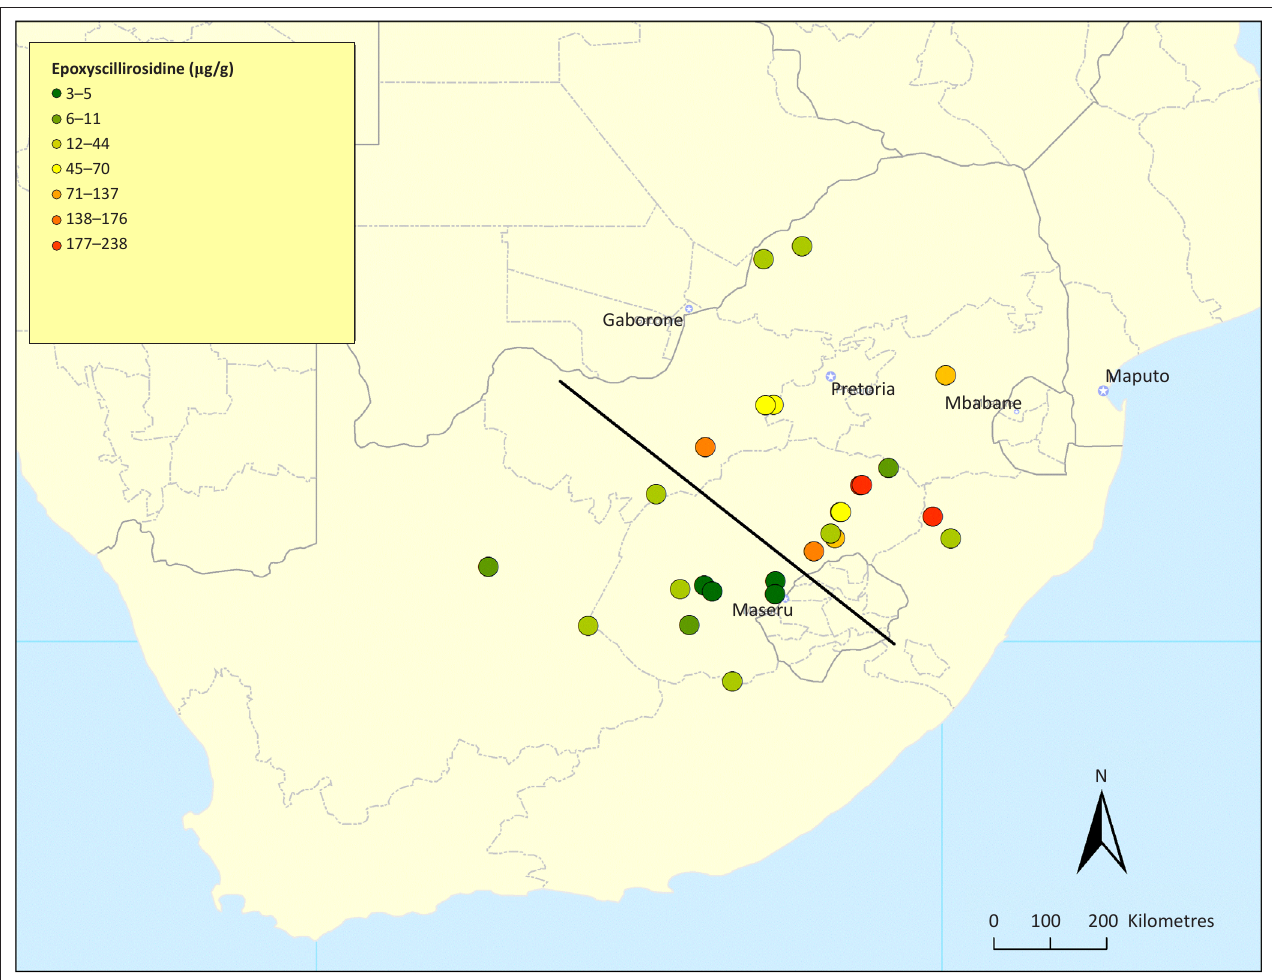
FIGURE 1: Mean epoxyscillirosidine concentrations of flowering Moraea pallida leaves ( n = 5) collected at 26 locations in South Africa to the north-east and south-west of a diagonal divisional line drawn between -26°N, 24°E to -30°N, 29°E.